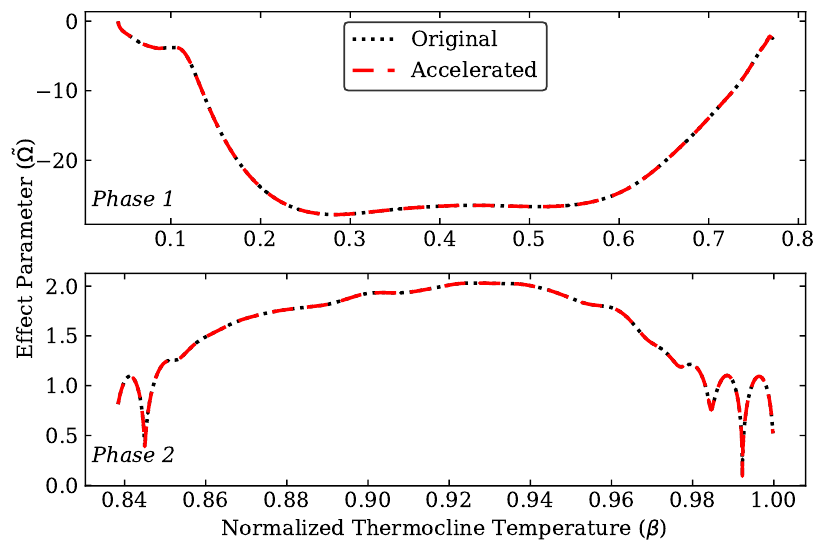
Figure 6. Scaled process curves of charging mode at the centerline.